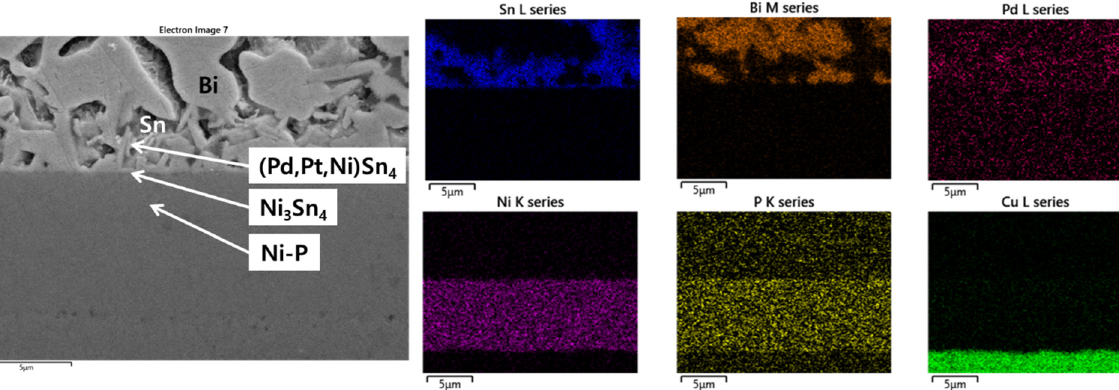
Figure 7. EDX elemental analysis of the Sn-58Bi-0.1Pt/ENEPIG interface after 500 h of aging.